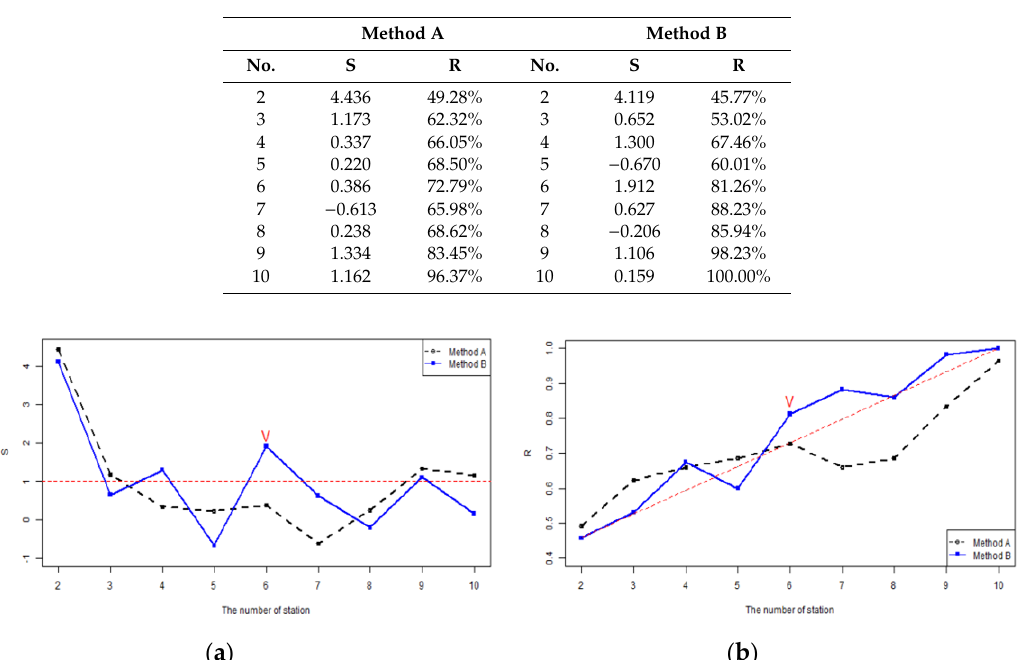
Table 5. RMSE result to determine the optimal number of stations for the rain gauge network.